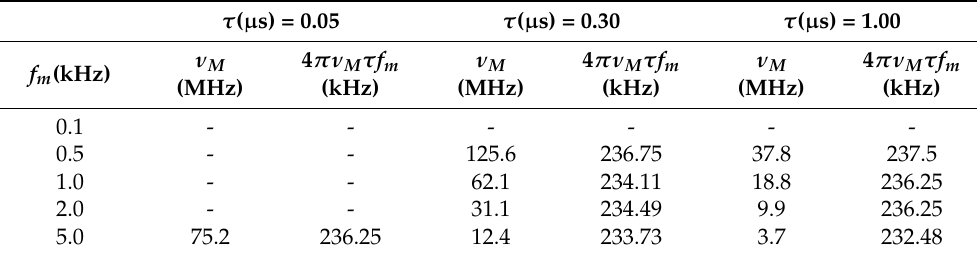
Table 1. The parameter ν M at different modulation frequencies and delay times; ‘-’ represents that modulation amplitudes do not reach ν M in these cases.